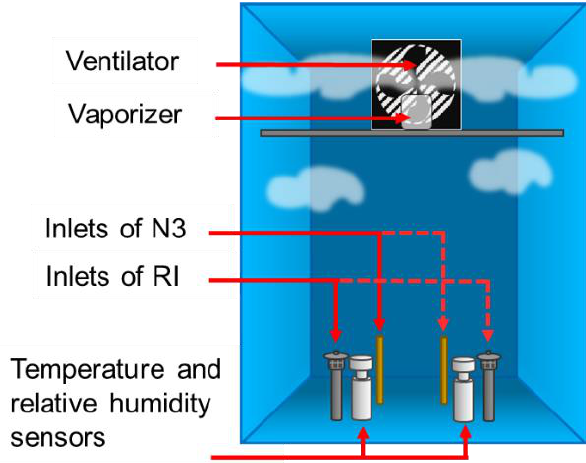
Figure 4. Test chamber configuration for experiments at different voltages.